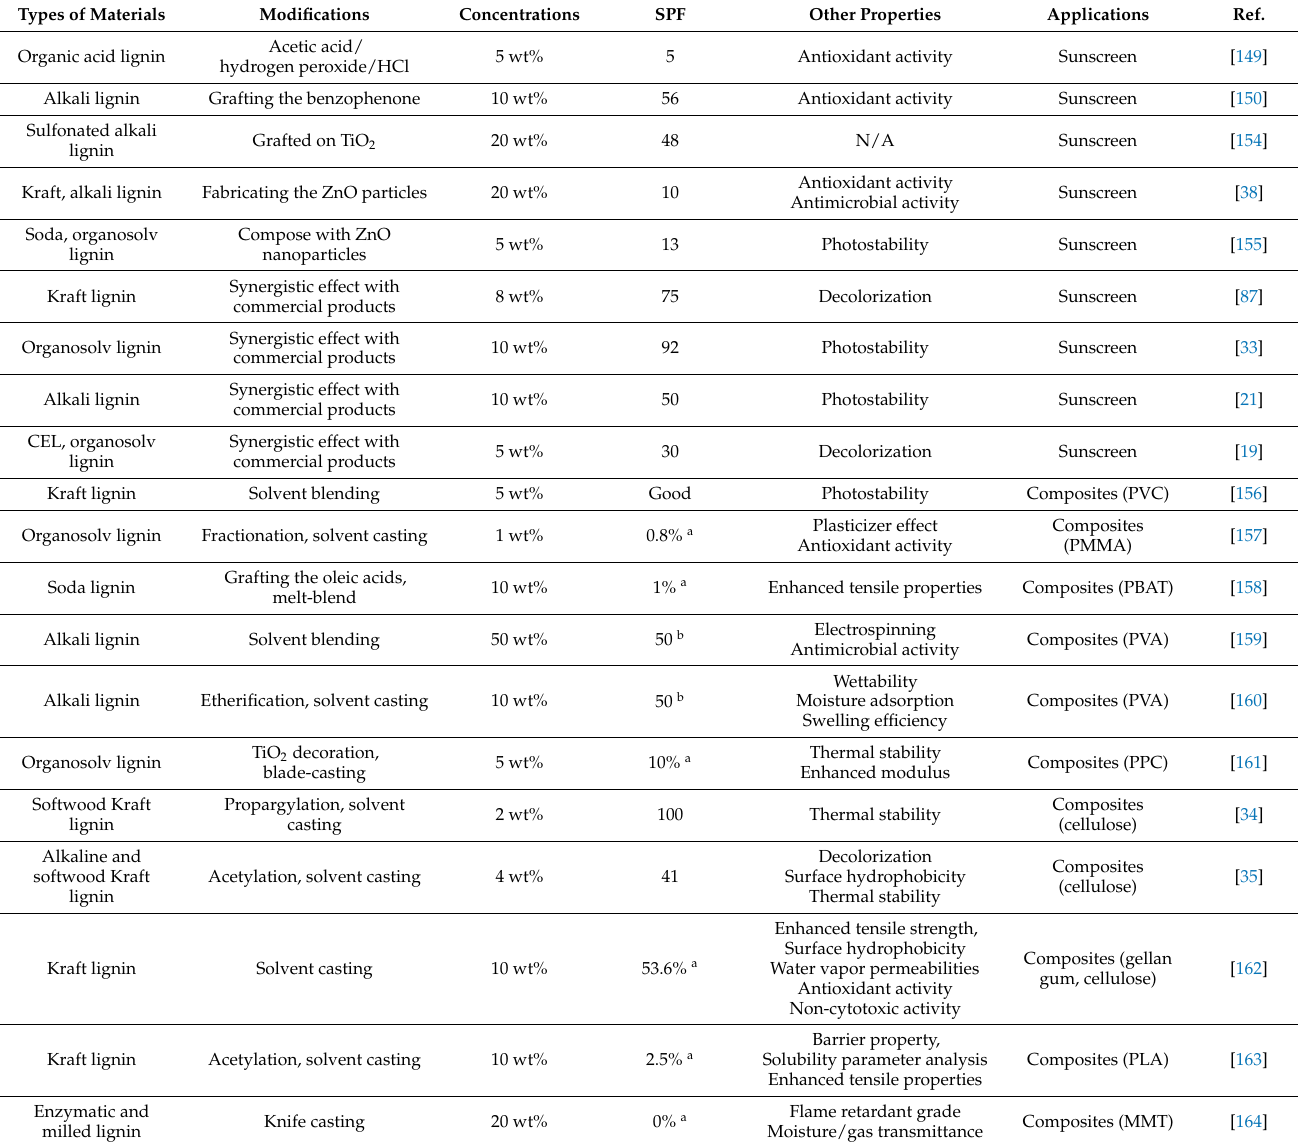
Table 6. Various valorization strategies of plant-based materials with their modification mechanisms, properties, and UV protection